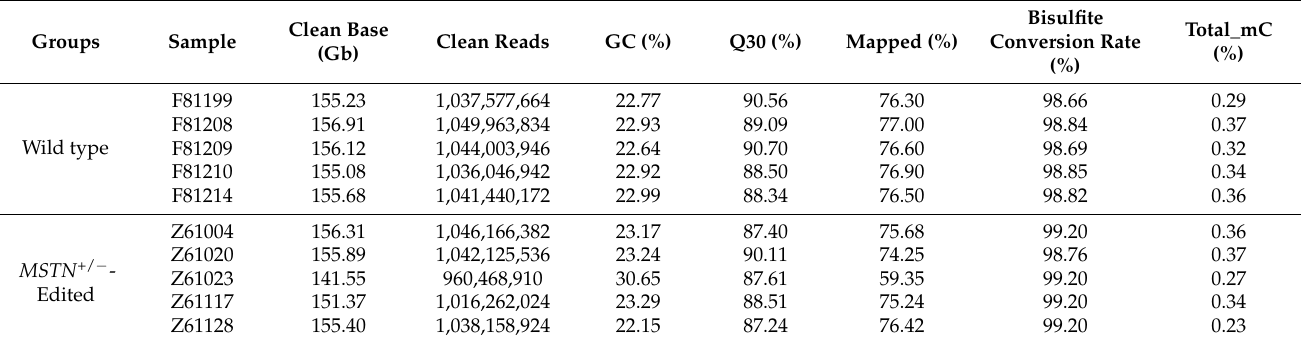
Table 1. Sequencing data by whole genome bisulfite sequencing (WGBS) for bovine MSTN +/ − -edited (Z) and wild type (F).